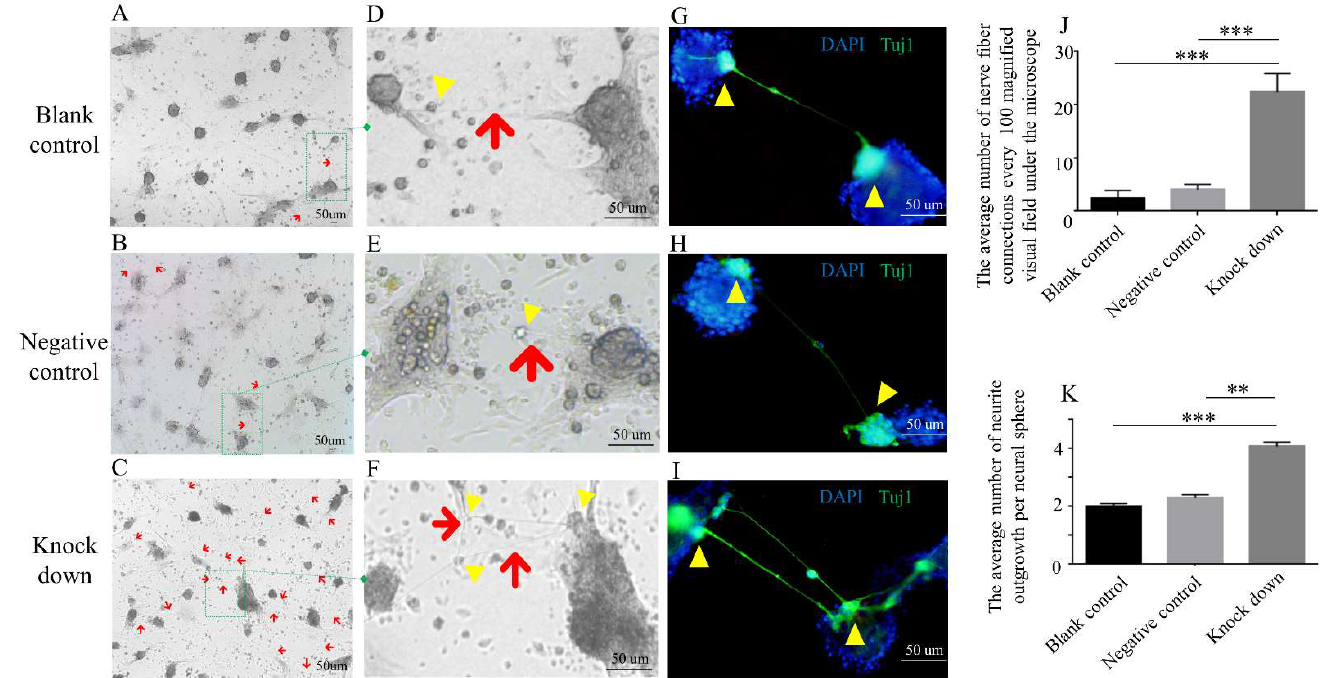
Figure 5. Comparison of neuron polarity among different neural sphere groups. ( A – C ) Nerve fiber phenotypes of neural spheres in different groups. ( D – F ) Partial enlarged drawing of ( A – C ) separately. (G–I) IF (Tuj1) showed the nerve fibers and neurites of neural spheres. Red arrow, nerve fiber; yellow arrowhead, neurite. ( J ) Comparison of average number of nerve fiber connections. ( K ) Comparison of average number of neurite outgrowth per neural sphere. **, p < 0.01; ***, p < 0.001, one-way ANOVA with Bonferroni post hoc, n = 3. Knockdown, infected with Doc2a -lentivirus; negative control, Lentivirus Luciferase Reporter negative control; blank control, cultured with an equal medium. Abbreviations: IF, immunofluorescence; DAPI, 4’,6-diamidino-2-phenylindole.